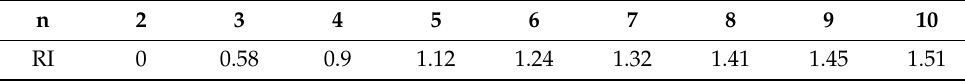
Table 5. AHP fundamental scale